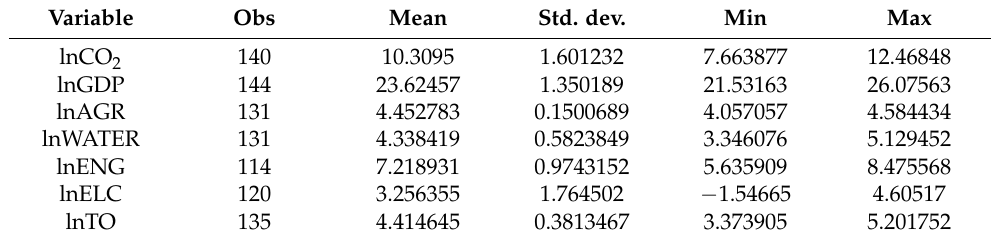
Table 2. Descriptive Statistics.